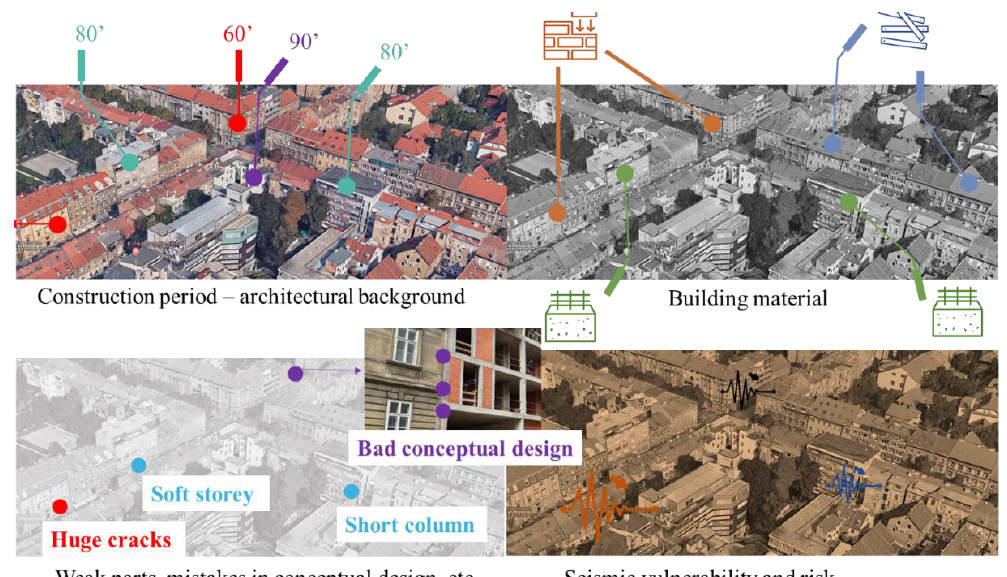
Figure 4. Predicting the seismic vulnerability of buildings and seismic risk of building blocks with the combination of various data.